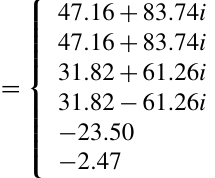
Figure 5. Comparision of normalised axial force and error of the compliant parallelogram